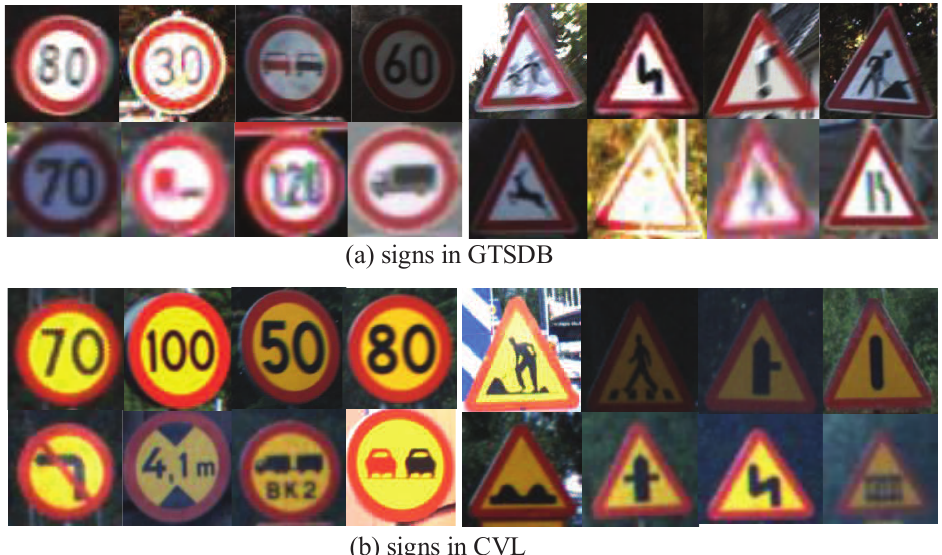
Figure 7. The signs from GTSRB and